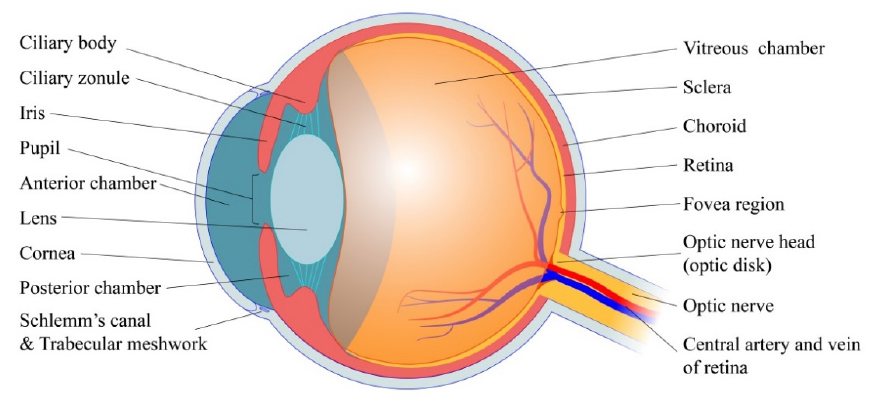
Figure 1. Physiology structure of the eye.